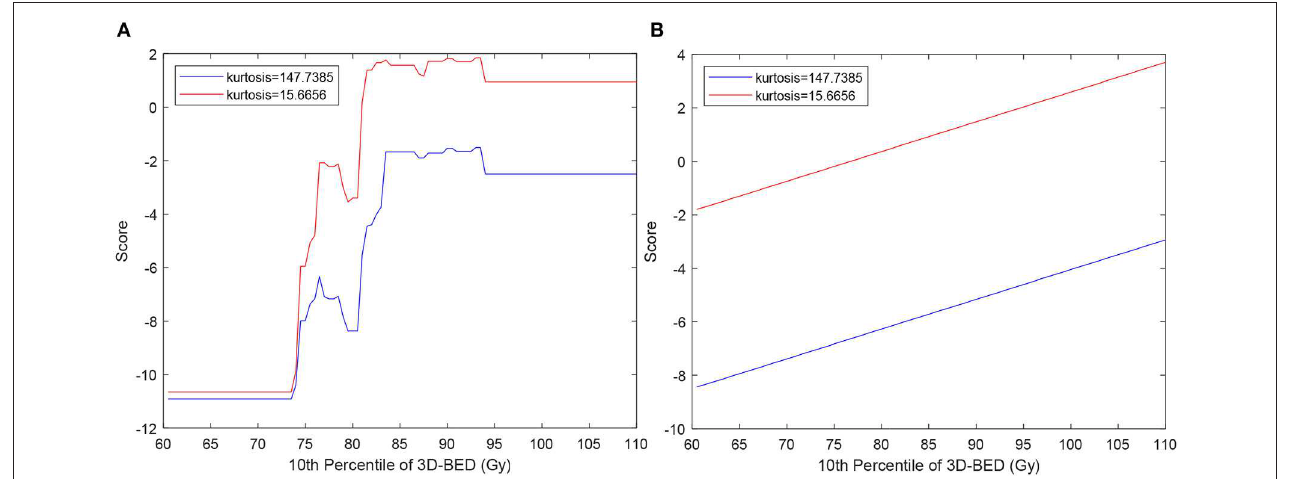
FIGURE 2 | Score function of EML (A) and SVM (B) used to classify patients vs. 10th percentile of 3D-BED in the PTV. The curves are calculated for values of kurtosis typical of patients at low and high risk of RIF, chosen as average of kurtosis in the 10 patients without RIF with lowest score (blue lines) and in 10 patients with RIF with highest score (red